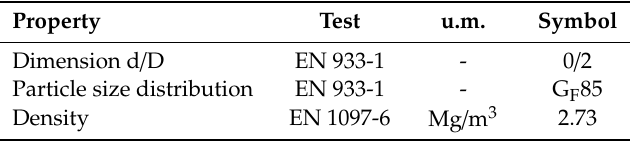
Table 2. Properties of limestone aggregates 0/2.